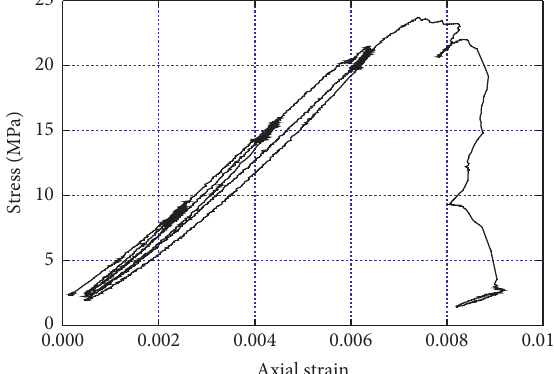
Figure 4: Stress-strain relation curve of coal